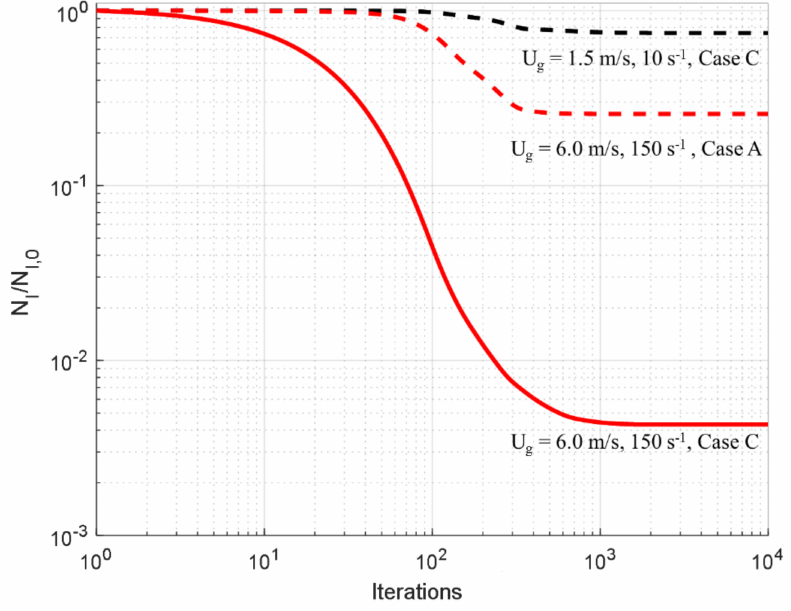
Figure 7. Convergence history of the exiting number of drops normalized to the entering number of drops in the injection size-class ( N I /N I, 0 ), showing three representative